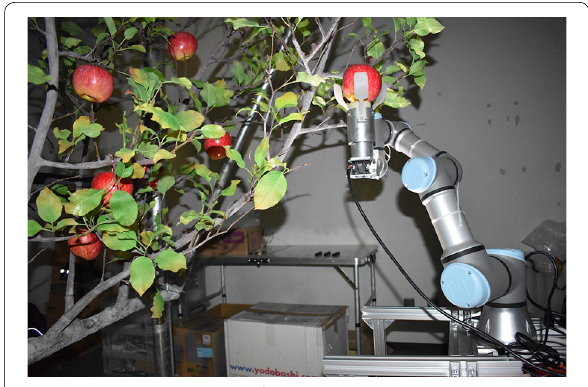
Fig. 15 Harvesting target apple